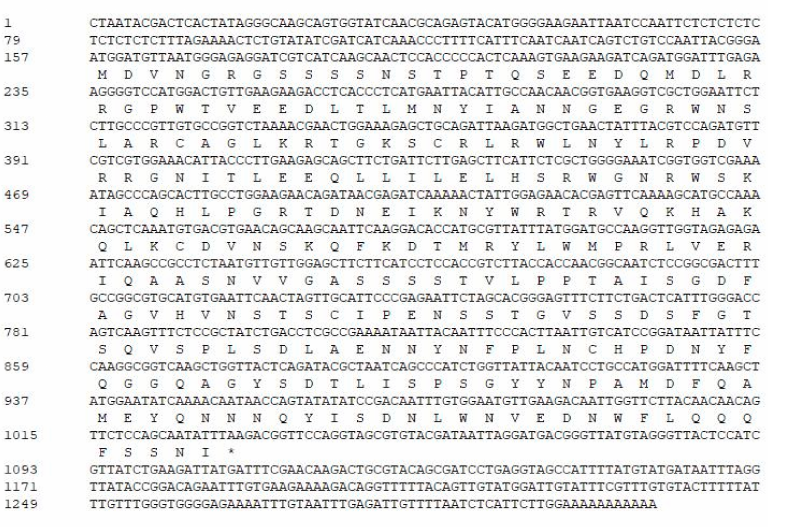
Figure 1. cDNA sequence of PlMYB108 and its deduced amino acid sequence. The deduced amino acid sequence is shown underneath the corresponding nucleotide sequence, the others are noncoding regions, and the stop code was indicated with